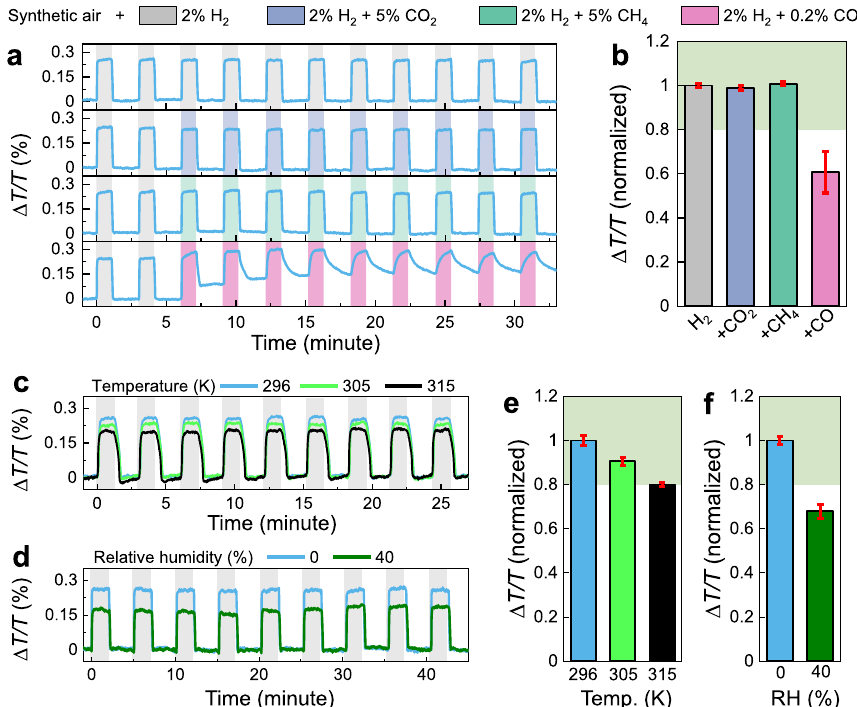
to 2 pulses of 2% H 2 followed by 9 5 50 to 9 pulses of 2% H 2 with different 80 Co 20 NP 5 to 5